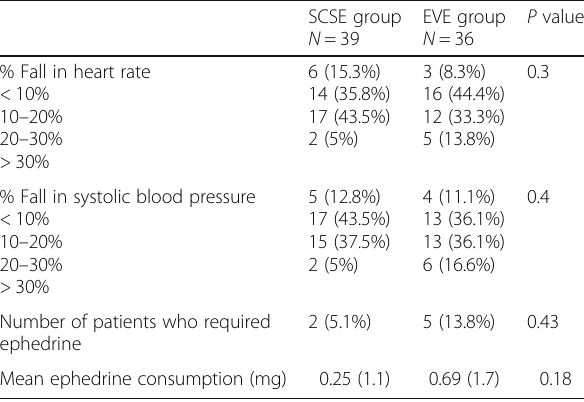
Table 2 Hemodynamic parameters